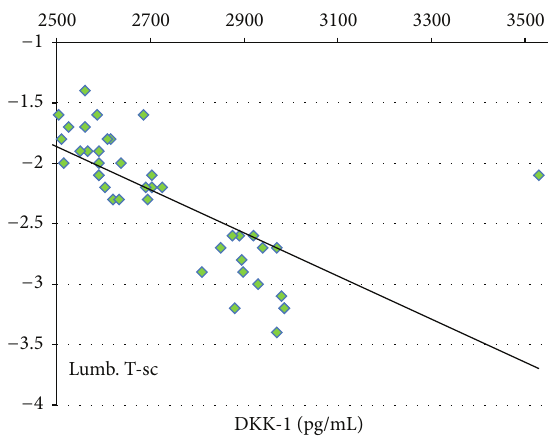
Figure 2: The negative correlation between serum DKK-1 levels and lumbar 𝑇 -score in both group I and group II.